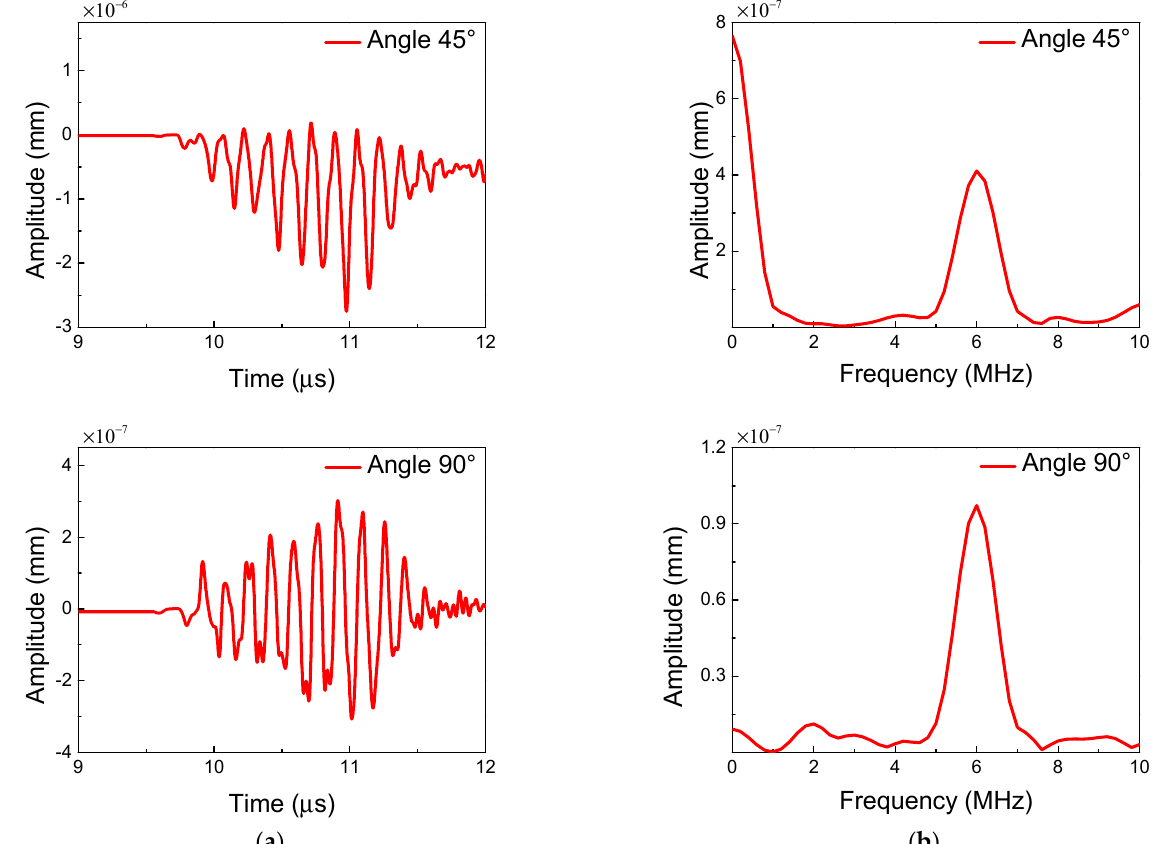
Figure 11. Waveforms ( a ) and frequency spectrums ( b ) of the resonant waves with different angles of micro-cracks ( c = 0.009375, f R = 6 MHz, μ = 0.3, L 1 = 40 mm, L 2 = 4 mm, L 3 = 36 mm).